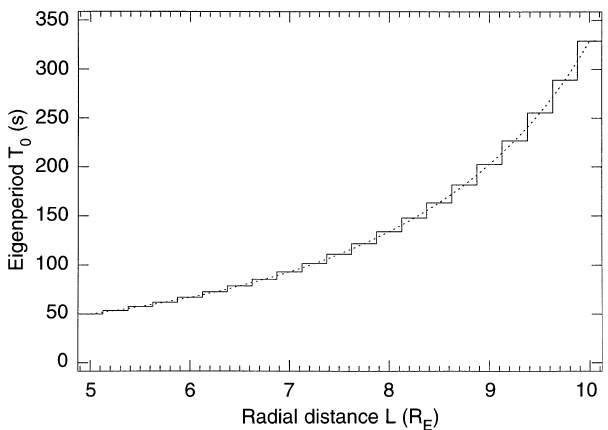
Fig. 2. The fundamental eigenperiod of the field lines in a continuum ( dotted line ) and in a discretized model plotted versus the equatorial distance to the flux tube in R